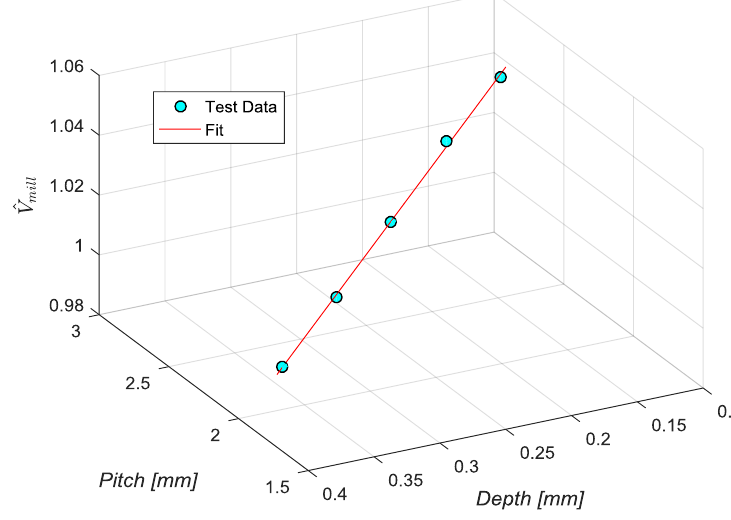
Figure 3. 3D visualization of ball speed as a function of pitch and